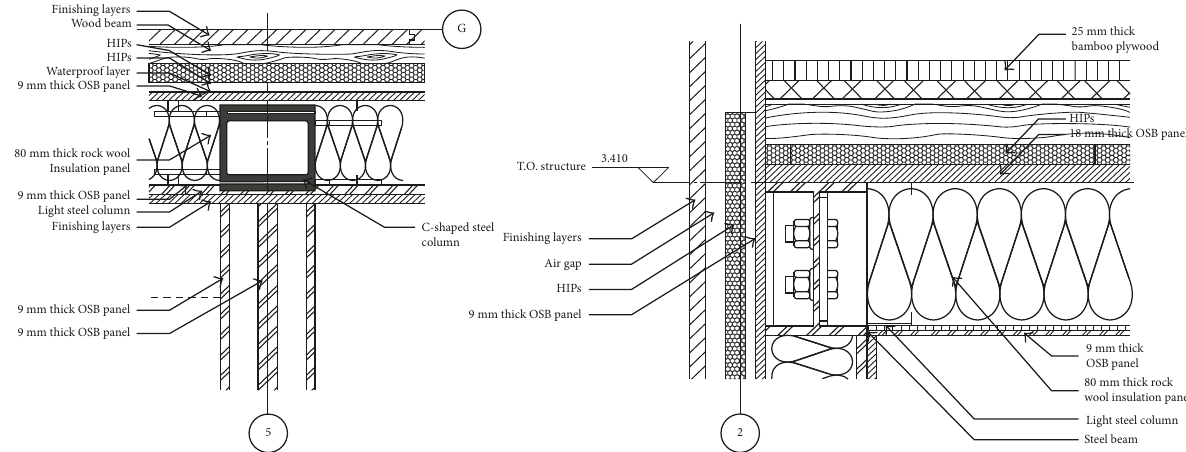
Figure 4: Exterior wall construction detail using the HIP’s insulation layer (source: authors’ own data).